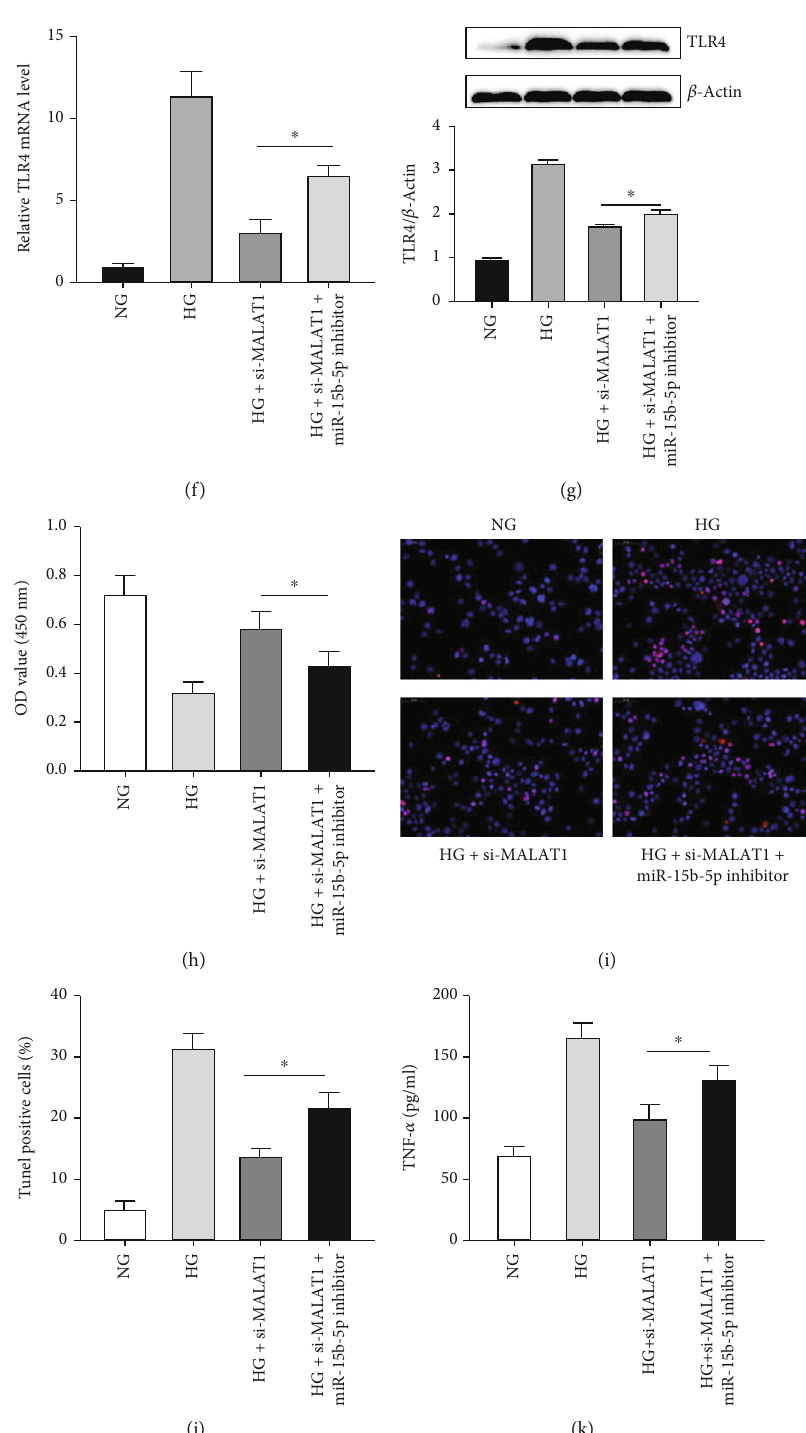
Figure 3: MALAT1 binds with miR-15b-5p, and an miR-15b-5p inhibitor reverses HG-induced HK-2 cell activity via MALAT1. (a) The binding sites between MALAT1 and miR-15b-5p and MALAT1-Mt sequence in the binding sites. (b, c) MALAT1 luciferase activity in HK-2 cells cotransfected with MALAT1-Wt or MALAT1-Mt vector and miR-15b-5p mimics or mimics NC. ∗ p < 0 : 05 versus the mimics NC group. (d) Anti-Ago2 RIP was carried out in HK-2 cells; then, the amount of MALAT1 or miR-15b-5p associated with Ago2 was detected by qRT-PCR. (e) Quanti fi cation of miR-15b-5p levels by qRT-PCR analysis in HK-2 cells transfected with si-MALAT1 under NG and HG conditions. (f, g) TLR4 mRNA by qRT-PCR analysis and protein levels by western blot analysis, (h) cell viability by CCK-8 assay, (i, j) cell apoptosis by TUNEL assay, and (k) TNF- α levels by ELISA analysis were evaluated in HG-induced HK-2 cells cotransfected with si-MALAT1 and miR-15b-5p inhibitor. ∗ p < 0 : 05 versus the HG+si-MALAT1